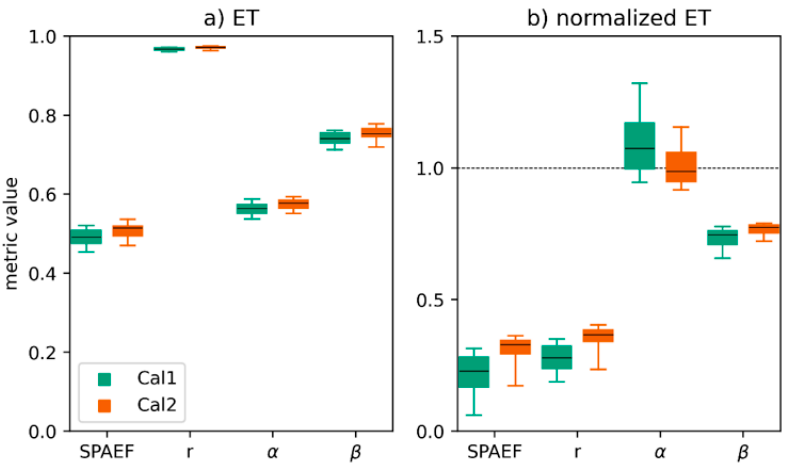
Figure 7. The spatial pattern evaluation of the balanced runs of Cal1 and Cal2 against the rainy- season ET climatology (panel ( a )) and the precipitation normalized climatology (panel ( b )). Metric values for SPAEF and its three components are presented. The boxplots show the median (black line), inter-quantile range (box) and 1st and 99th percentiles (whiskers).